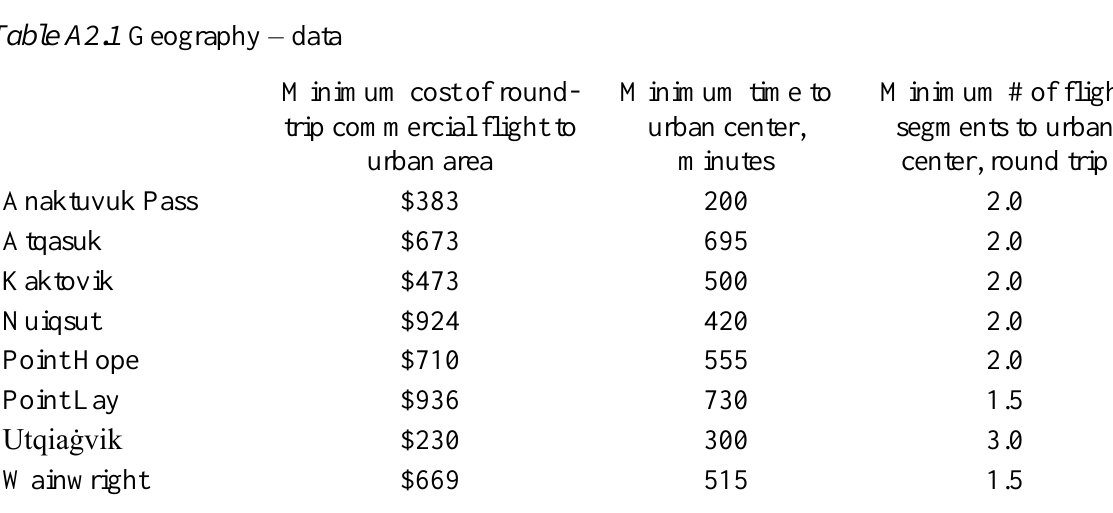
Table A2.1 Geography – data